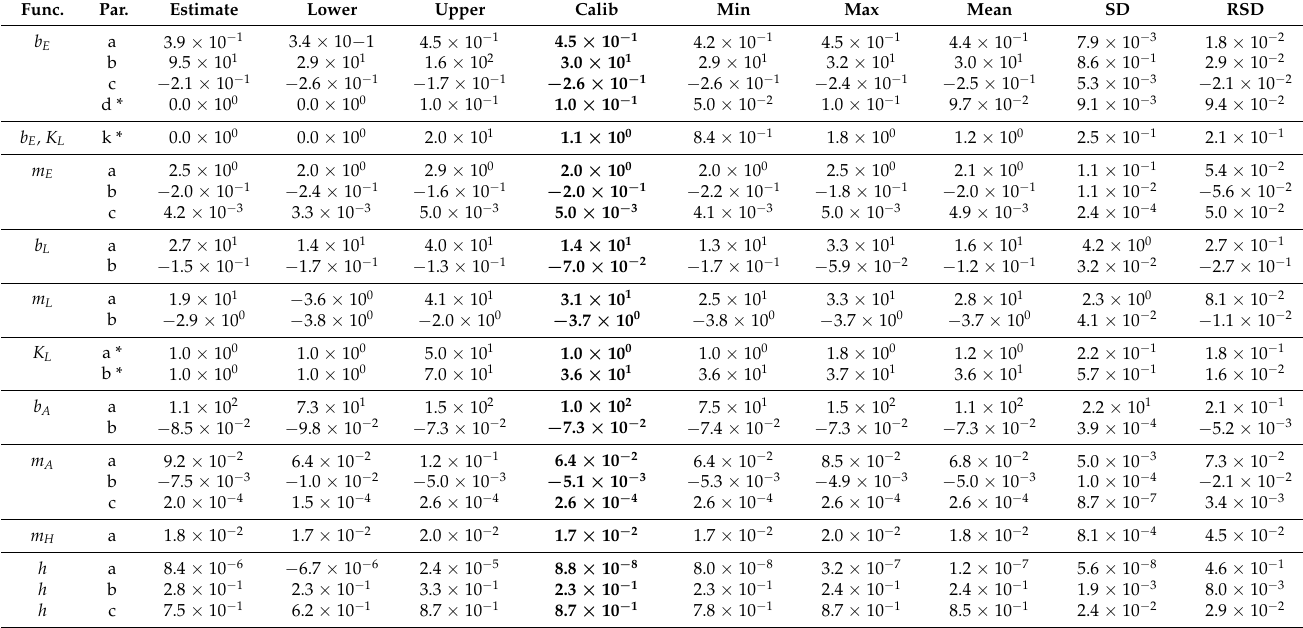
Table 2. Parameter estimates for Equations (6)–(14) for the Cx. pipiens / restuans mosquito model. The estimates are the values for a specific function fitted to literature data, and the according lower and upper margin (estimate ± SE). Values estimated to our best knowledge, i.e., not based on literature data, are indicated by an asterisk (*). Furthermore, the model calibration with the lowest RMSE (in bold), as well as the minimum, maximum, mean, standard deviation ( SD ) and relative standard deviation ( RSD ), obtained by the 30 runs of the genetic algorithm (training data set), are